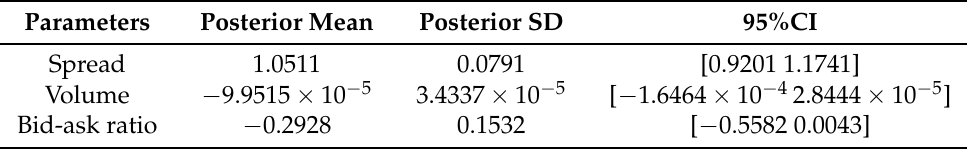
Table 19. Estimated parameters about limit order book (27 July 2016, AGH, Tokyo, Japan).